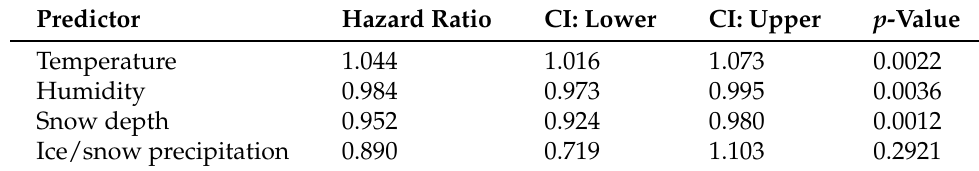
Table 6. Hazard ratios from delayed to punctual states.